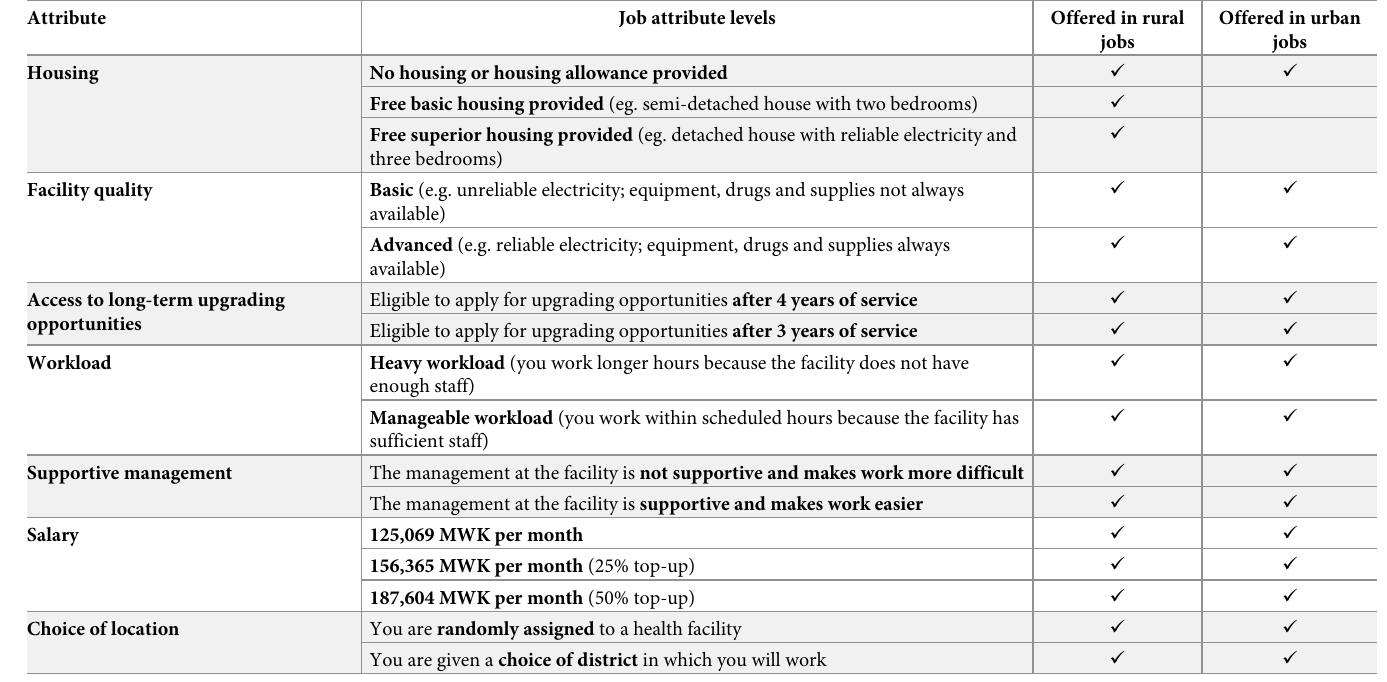
Table 1. Job characteristics included in the discrete choice experiment questionnaire.